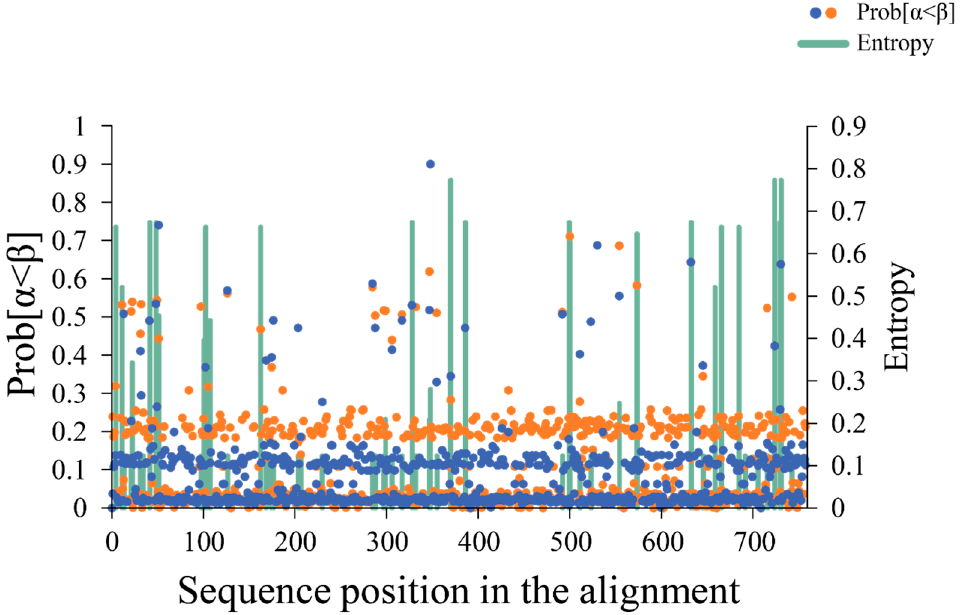
Figure 3. Entropy and pressure selection analysis. The entropy analysis results of the P3 region of CVB4 isolated from AIP and HCP groups are indicated by green bars, while sites with amino acid entropy values > 0.6 are considered highly variable. The orange and blue circles are the pressure selection results of each amino acid site in the P3 region of CVB4 isolated from AIP and HCP groups, respectively. Prob [ α < β ] is the posterior probability of positive selection at a site. Generally, posterior probabilities > 0.9 are strongly suggestive of positive selection.